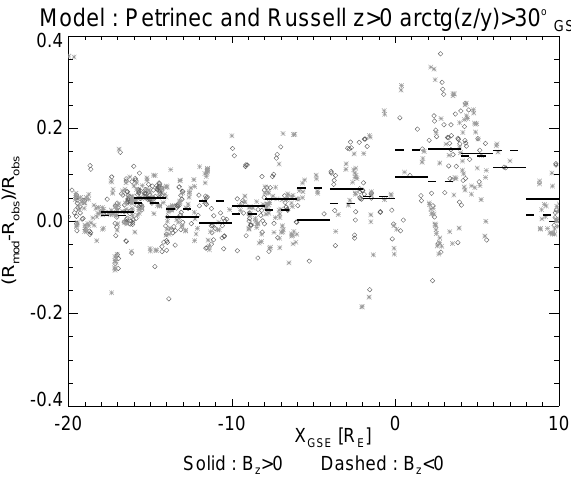
Fig. 5. The same data as in Fig. 4 but sorted according to IMF B Z .